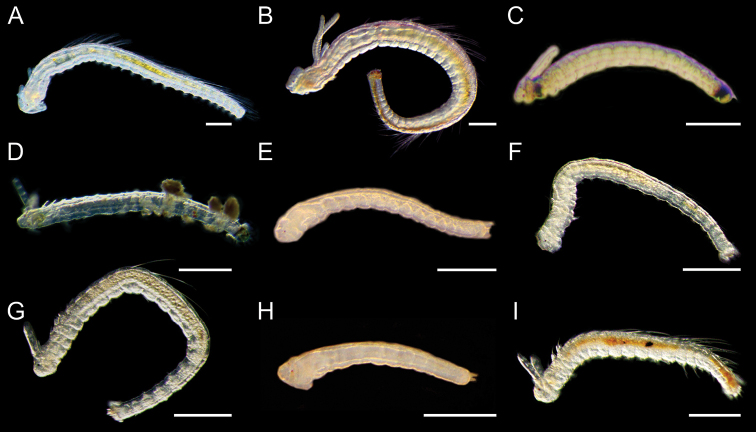
Light micrographs showing the morphologies of living spionid larvae of genera Paraprionospio and PrionospioA, BParaprionospio
coora, lateral view of 25‐chaetiger (A) and 33‐chaetiger larvae (B) C, DPrionospio
krusadensis, lateral view of 17‐chaetiger larvae E–GPrionospio
membranacea, lateral view of 15‐chaetiger (E), 20‐chaetiger (F), and 24‐chaetiger larvae (G) H, Prionospio sp. 1, lateral view of 11‐chaetiger larva IPrionospio sp. 2, lateral view of 19‐chaetiger larva. Scale bars: 300 μm.